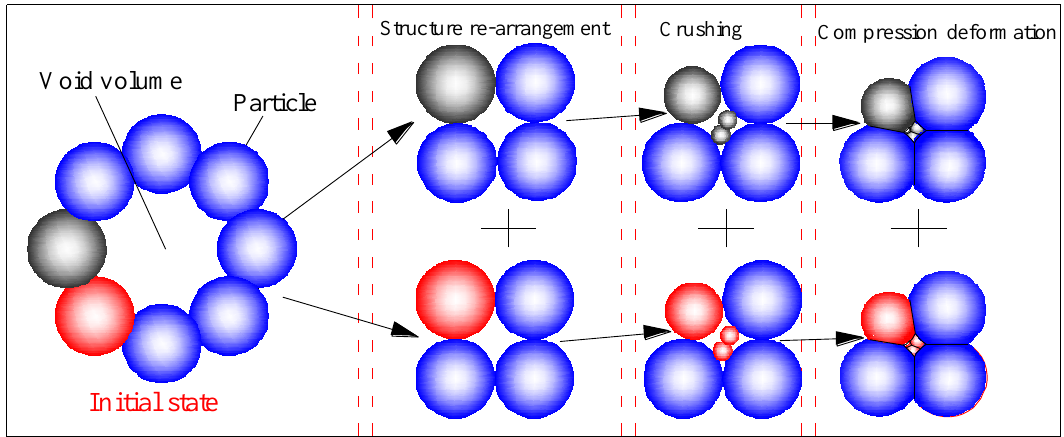
Figure 13. Schematic diagram of porosity change of broken coal samples during the loading stage.